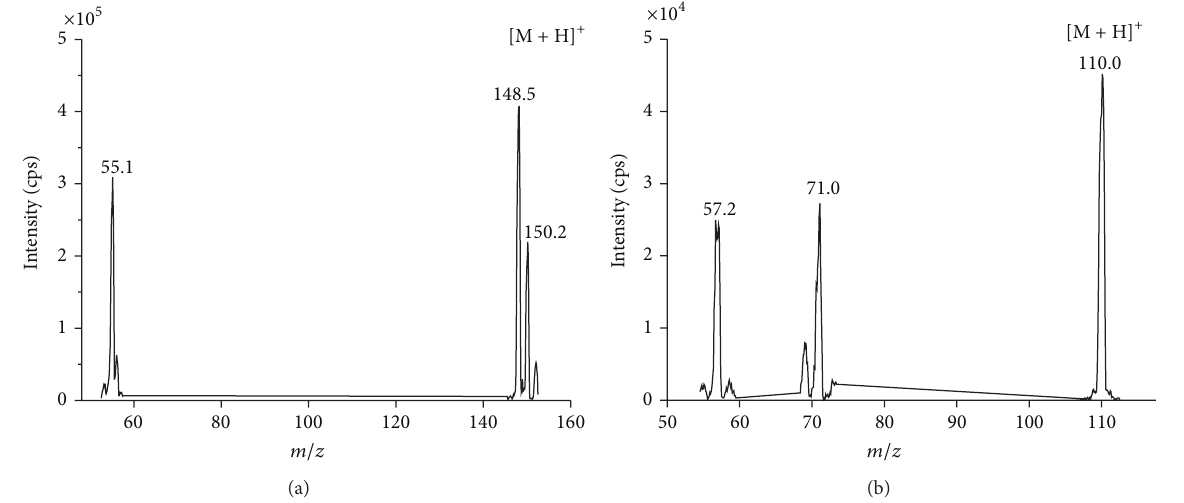
Figure 1: Tandem mass product ion spectra of matrine (a) and acetaminophen (b).